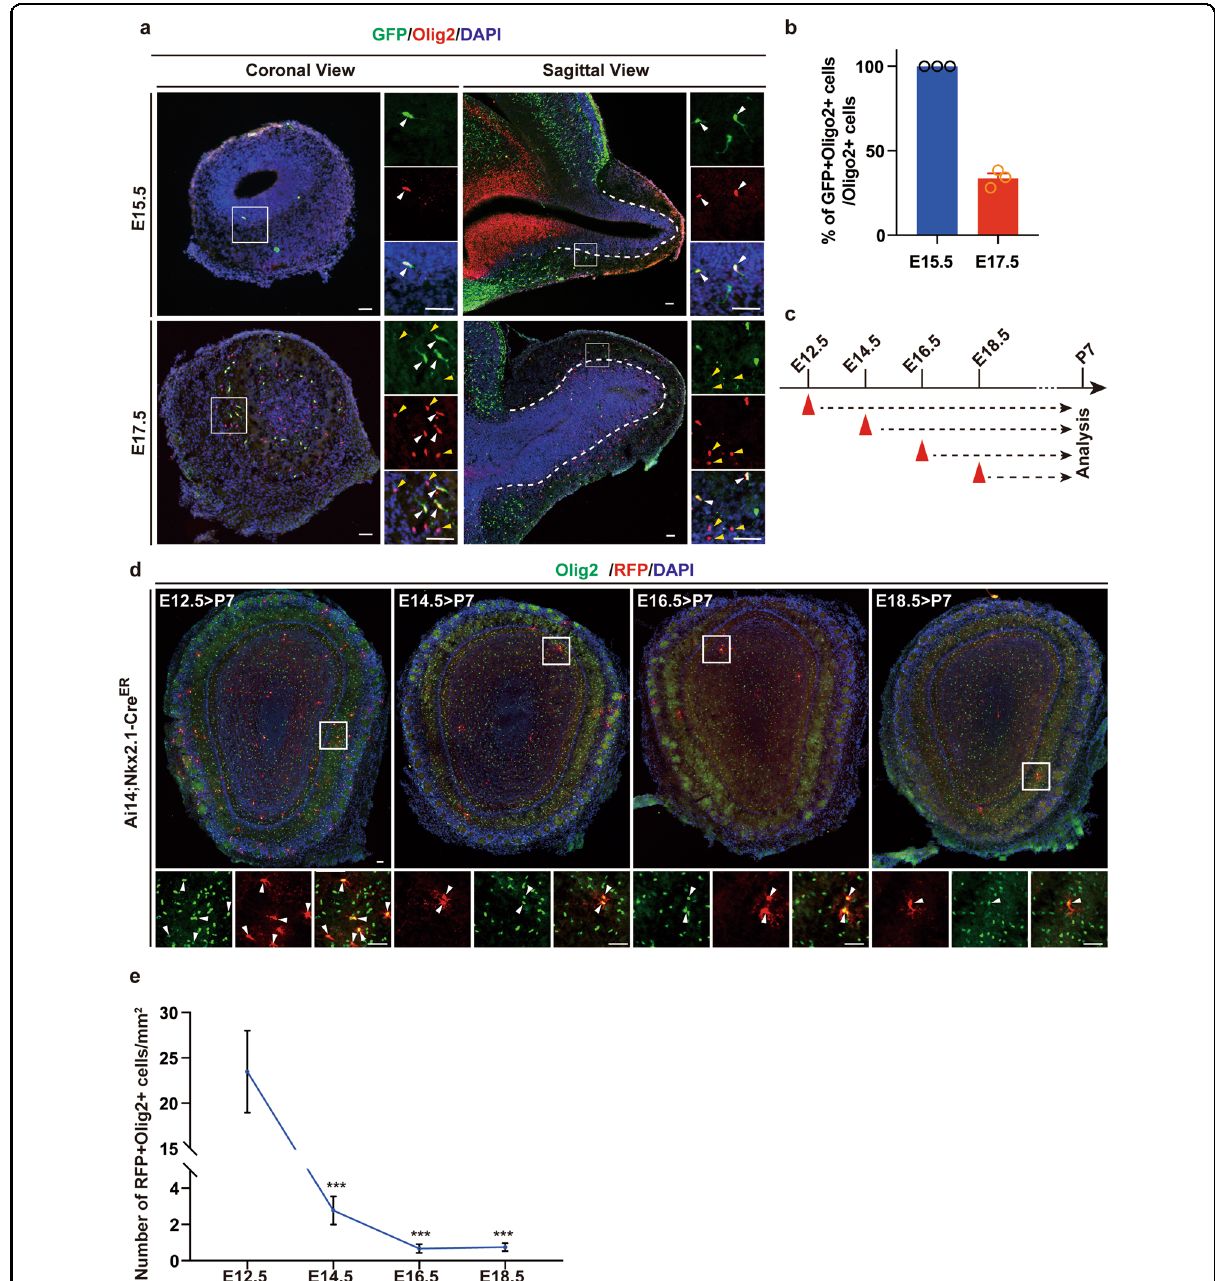
Fig. 1 Nkx2.1 lineage generates OPCs in the OB at early stages. a Coronal and sagittal sections of the OB from Ai3;Nkx2.1Cre mice stained for GFP and Olig2 at E15.5 and E17.5. White arrowheads indicate Nkx2.1-positive RGCs derived OPC lineage cells (GFP + Olig2 + ). Yellow arrowheads show other source derived OPC lineage cells (Olig2 + GFP − ). The dashed lines represent the boundary of the olfactory ventricle zone and the granule cell layer. The small mono-channels are the higher magni fi cation of the solid square boxes. Scale bar: 50 μ m. b Quanti fi cation of Nkx2.1-positive RGCs derived Olig2-positive cells at E15.5 and E17.5. Data are presented as mean ± SEM. At least 3 mice were analyzed for each time point. c Experimental paradigm shows that tamoxifen (TAM) was injected at E12.5, E14.5, E16.5, and E18.5 and sacri fi ced at P7. d Confocal images of sections of the OB from Ai14;Nkx2.1-Cre ER mice stained for Olig2 and RFP. Arrowheads indicate the RFP- and Olig2-double-positive cells. Scale bar: 50 μ m. e Quanti fi cation of the number of Nkx2.1-derived OPC lineage cells generated at E12.5, E14.5, E16.5, and E18.5. One-way ANOVA, data are presented as mean ± SEM. *** p < 0.001 ( n =